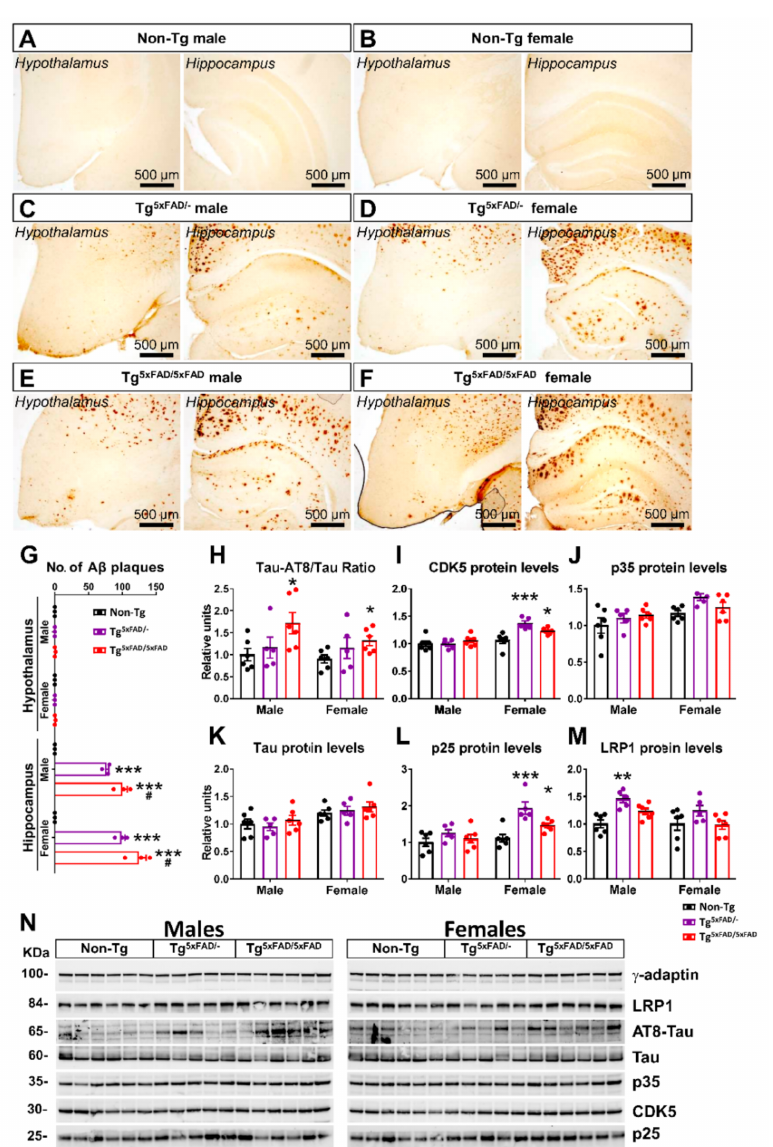
differences between males and females and a different pattern of cytokine release profile.